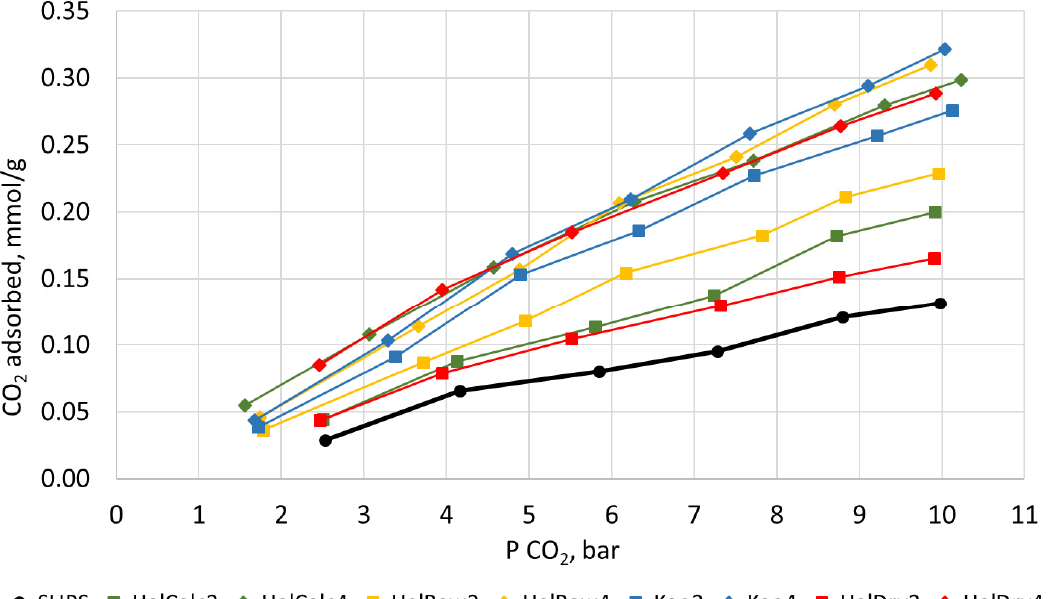
Figure 3. The experimental CO 2 adsorption equilibrium data in a P CO2 (bar)—adsorption equilibrium capacity q e (mmol/g).